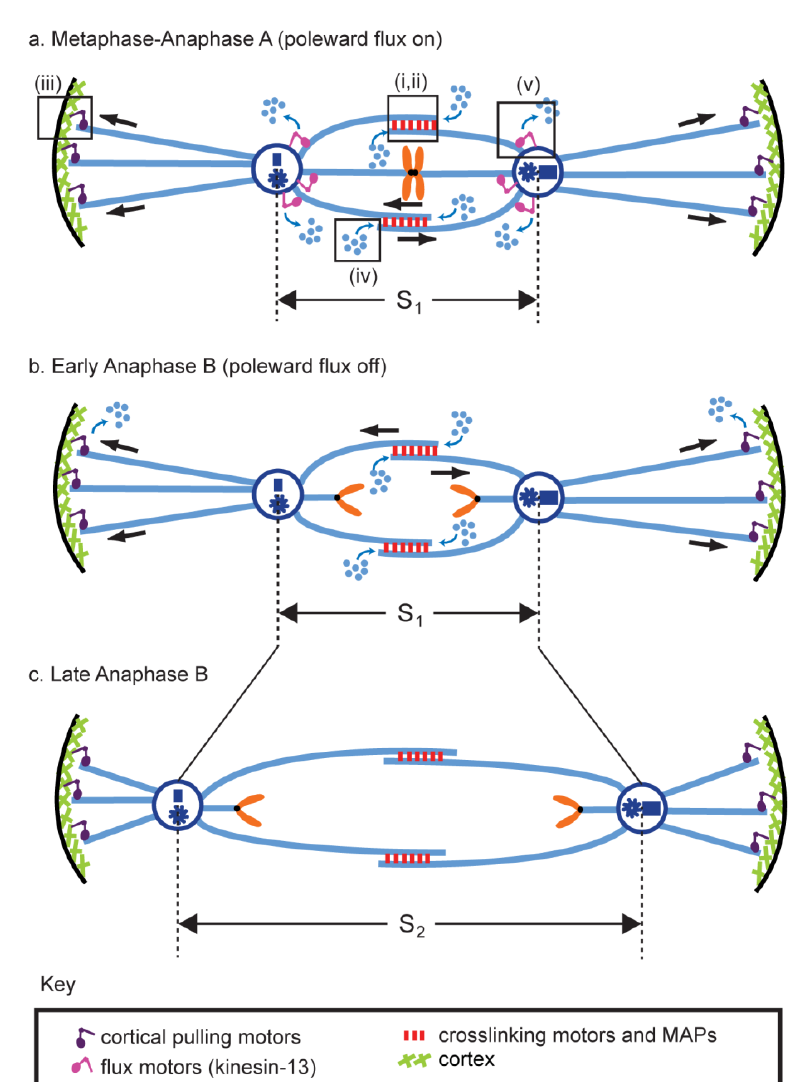
Figure 2. Anaphase B in an idealized and simplified mitotic spindle. The spindle is depicted ( a ) during metaphase-anaphase A (aka pre-anaphase B), when poleward flux is “on” maintaining the spindle at a constant length, S 1 ; ( b ) at the start of anaphase B, when flux is turned off so that the spindle can begin to elongate; and ( c ) at late anaphase, when the spindle has completed its elongation to length S 2 . The major biochemical modules are shown, namely midzone (i) pushing or (ii) braking by MT crosslinkers, particularly kinesin-5 motors and Ase1p MAPs; (iii) cortical pulling by depolymerizing proteins and/or dynein motors attached to the cortex that respectively disassemble or translocate along aMTs to pull them and the attached poles outward; (iv) ipMT plus end dynamics, notably net polymerization; and (v) ipMT minus end depolymerization manifest as poleward flux. In most cells anaphase B starts after anaphase A (as depicted here), but there are exceptions, e.g., in mouse eggs anaphase B precedes anaphase A [42]. Unless otherwise indicated, in this and all other figures, arrows depict direction of movement of ipMTs and